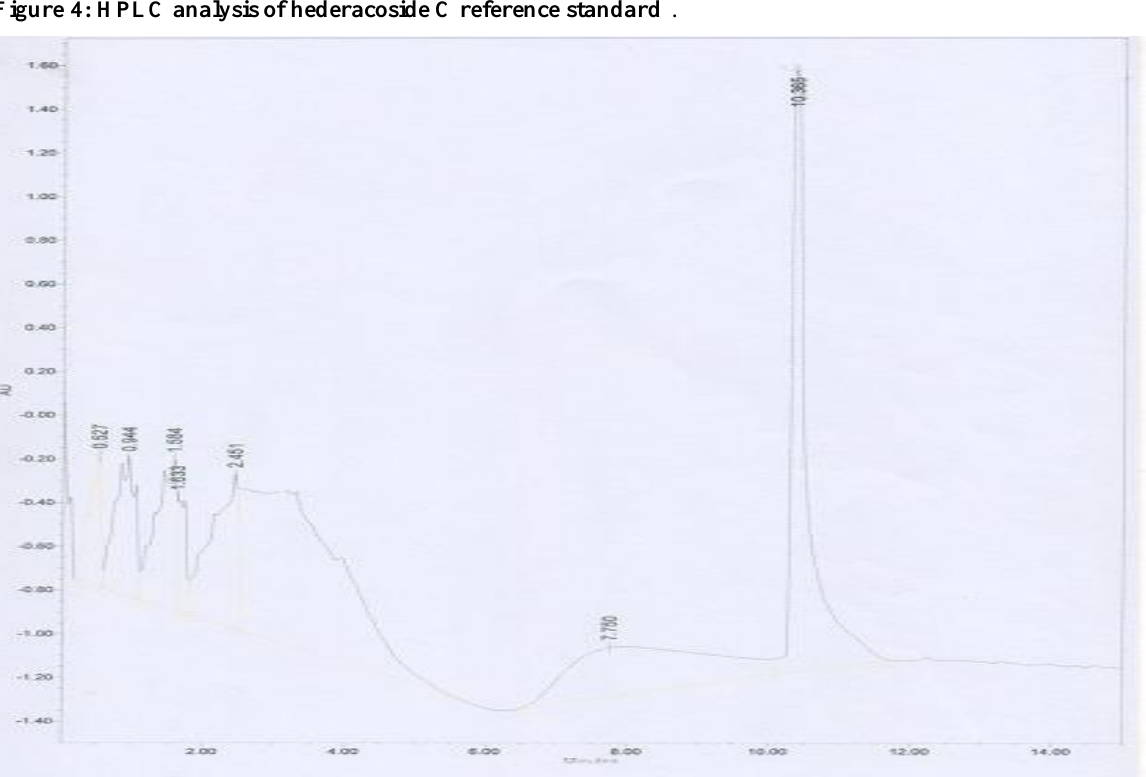
Figure 5: HPLC analysis of isolated hederacoside